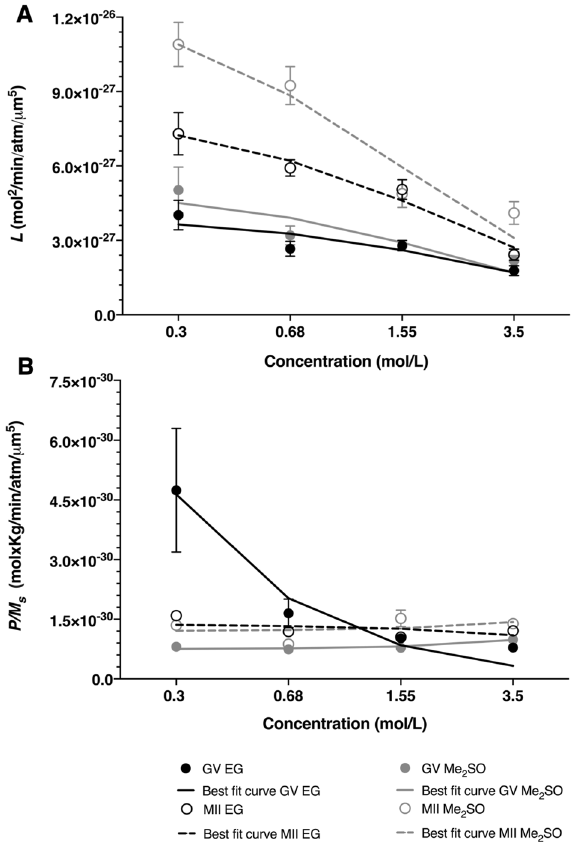
Figure 3. Water permeability and solute permeability GV (closed circles) and MII (open circles) oocytes in the presence of increasing concentrations of CPA (EG (black) or Me 2 SO (gray)) for the nondilute solution model ( A , B , respectively). Best-fit curve for the concentration dependent model is represented in solid black line (GV EG), dotted black line (MII EG), solid gray line (GV Me 2 SO) and dotted gray line (MII Me 2 SO). Unless indicated otherwise, data are given as the mean ±